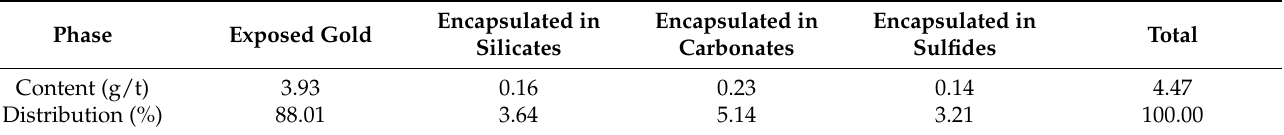
Figure 9. Gold chemical phase analysis results of the raw ore and the roasted product under optimal conditions. Table 5. Gold chemical phase analysis results of the roasted product under optimal